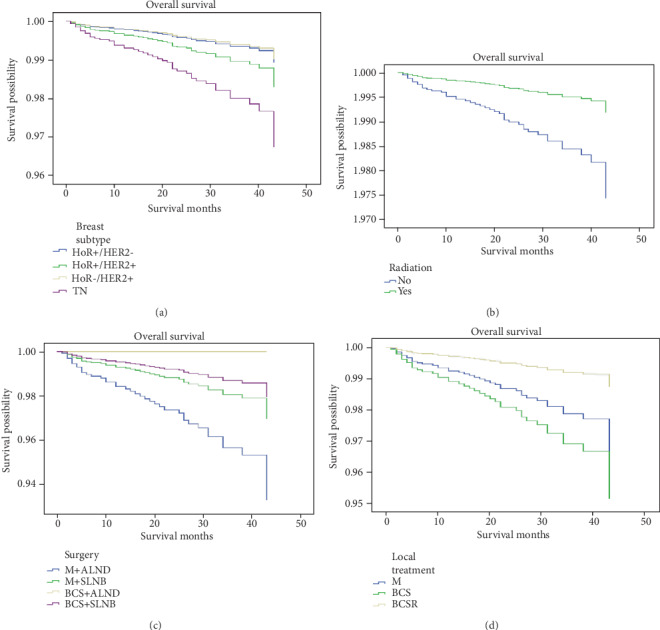
Weighted Kaplan-Meier curves of overall survival (OS) in subgroup analysis. (a) OS is based on breast subtype. (b) OS is based on radiotherapy. (c) OS is based on surgery. (d) OS is based on local treatment.